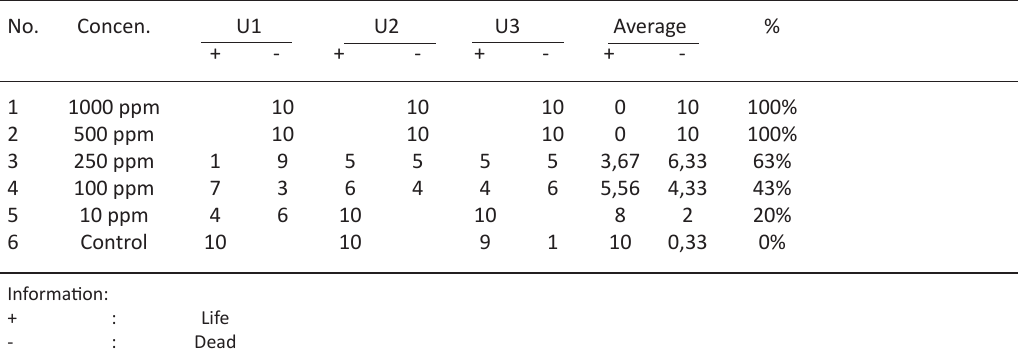
Table 1. Test Results for the Brine Shrimp Lethality Test extract of Bacillus sp . in Artemia salina leach larvae